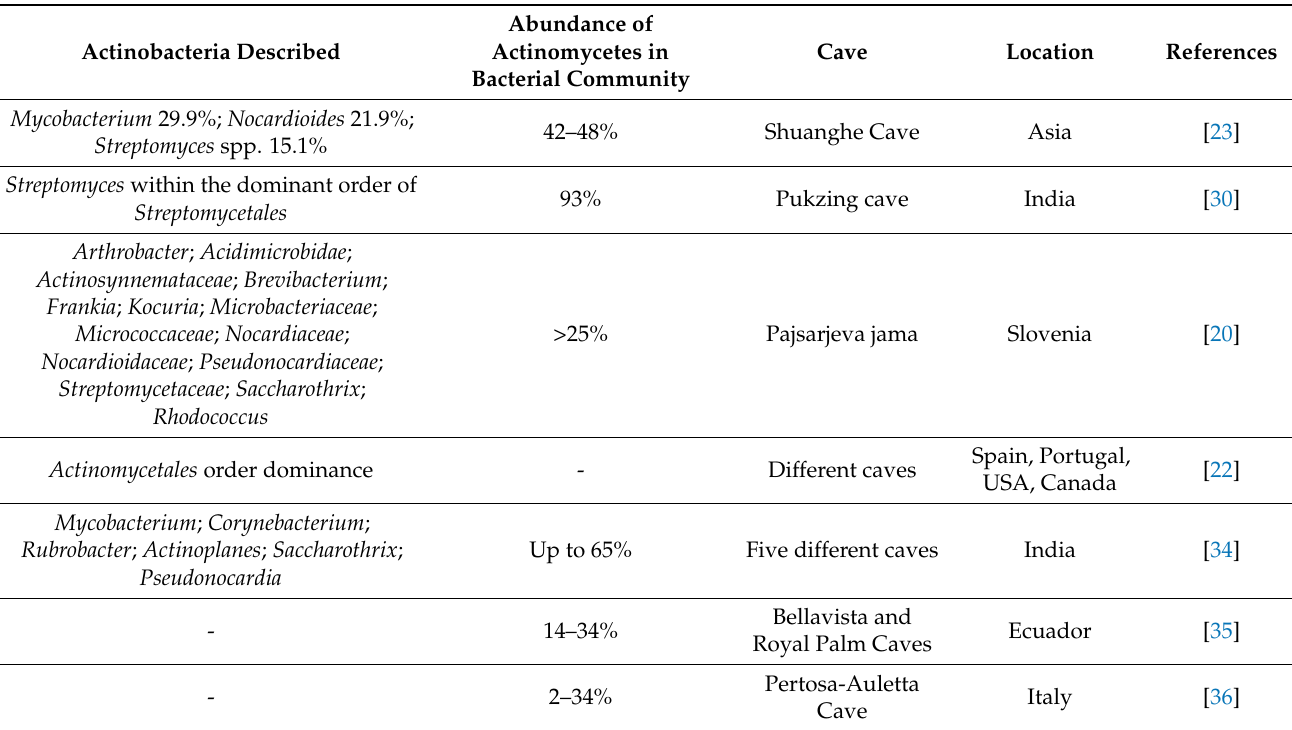
Table 2. Summary of the actinomycetes characterised in caves